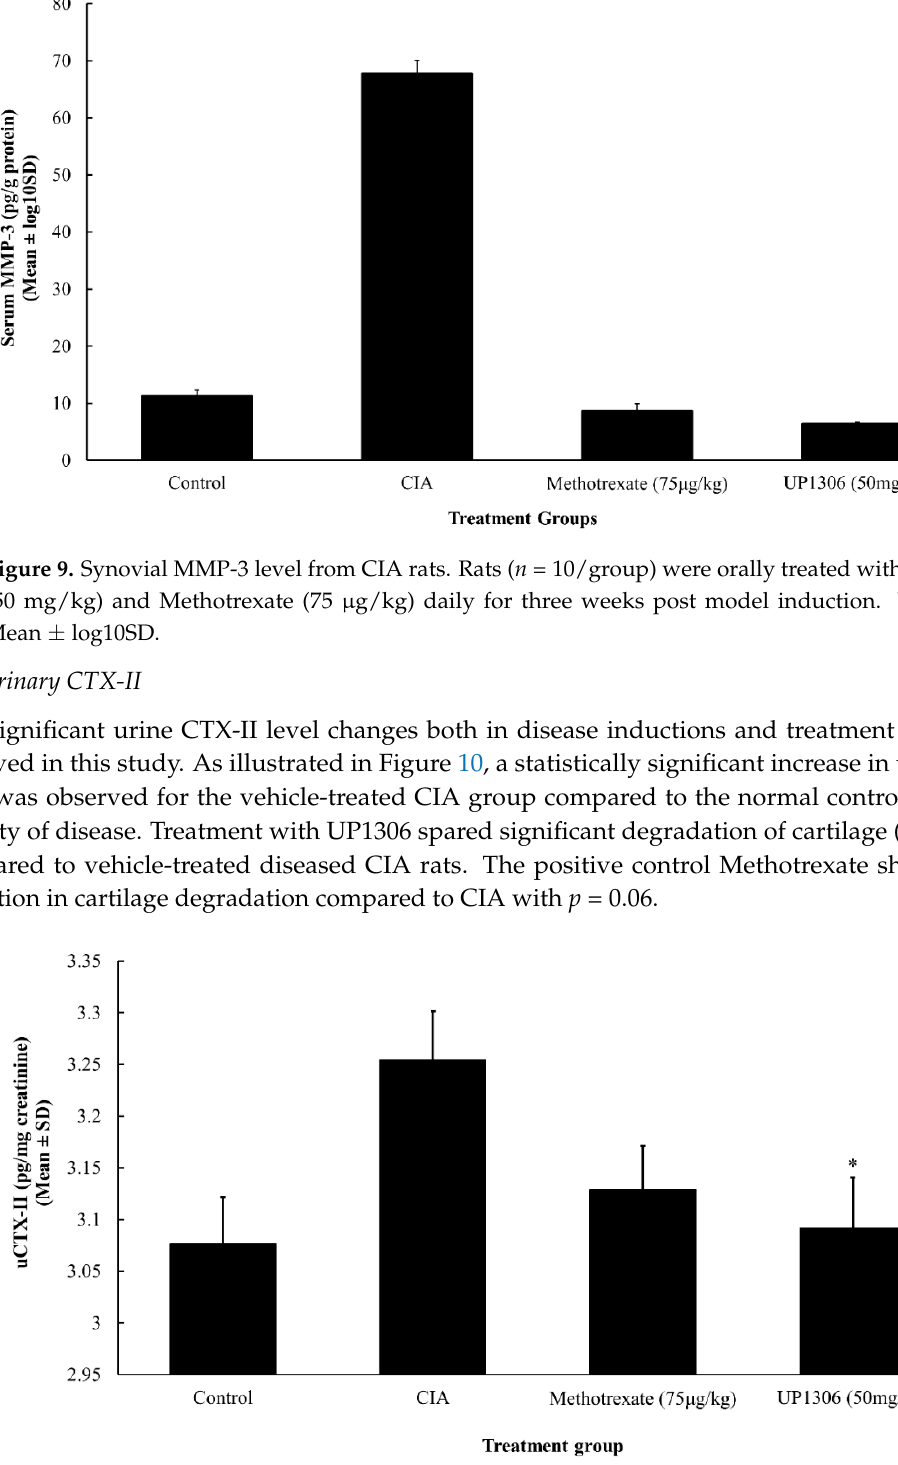
Figure 10. Effect of UP1306 on rat urinary CTX-II level normalized with creatinine in CIA model. Rats ( n = 10/group) were orally treated with UP1306 (50 mg/kg) and Methotrexate (75 µ g/kg) daily for three weeks post model induction. Data are mean ± SD. * p ≤ 0.05 vs. vehicle treated CIA.